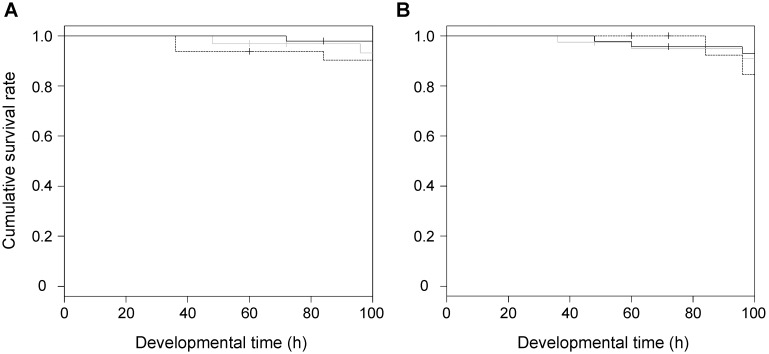
Cumulative survival rate of Thrips palmi larvae (Kaplan-Meier).(A) The virus-free larvae were reared on the healthy watermelon leaves (n = 47, solid line), on the thrips-damaged leaves (n = 32, dashed line), and on the thrips-inoculated leaves (n = 32, grey line). (B) The viruliferous (infected with Watermelon silver mottle virus) larvae were reared on the healthy watermelon leaves (n = 46, solid line), on the thrips-damaged leaves (n = 26, dashed line), and on the thrips-inoculated leaves (n = 40, grey line).